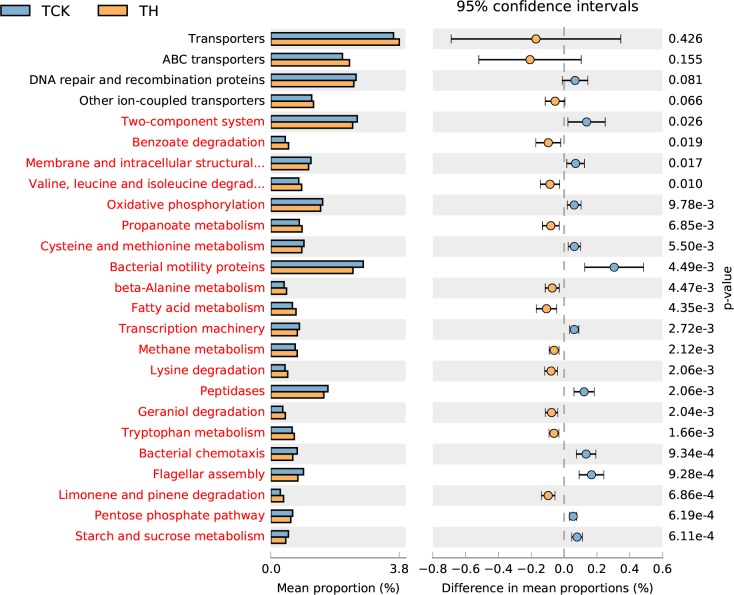
Top-25 functional abundance-difference analysis between the TCK and TH.TH denotes the antibiotic-treated PWNs receiving the H-level of α-pinene. TCK denotes the antibiotic-treated PWNs in the control group. The left side of the chart shows the abundance of different functional groups in the two groups of samples. The right side shows the difference in the ratio of the functional abundance in the 95% confidence interval. The functional group shown in red indicates p < 0.05.